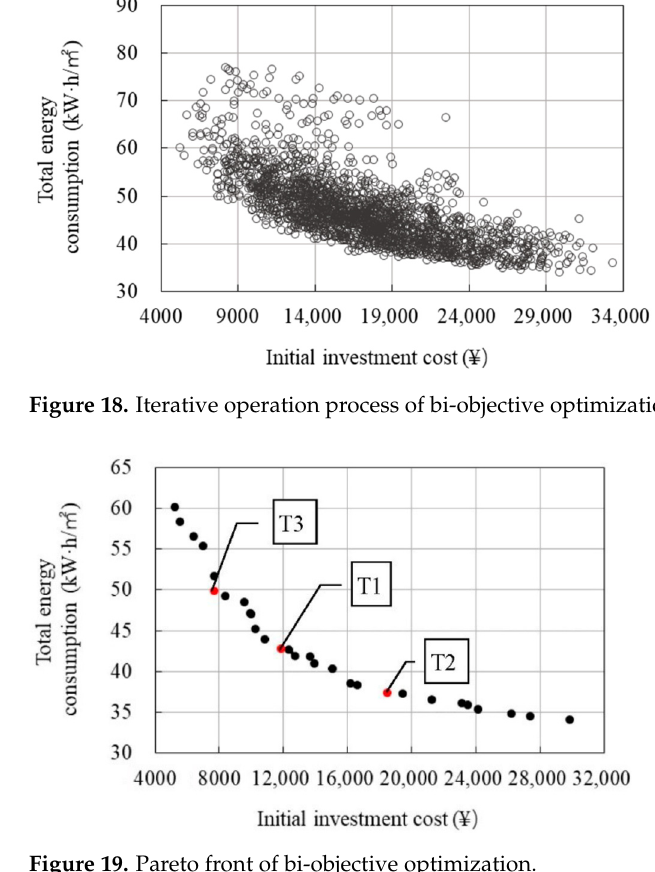
Figure 19. Pareto front of bi-objective